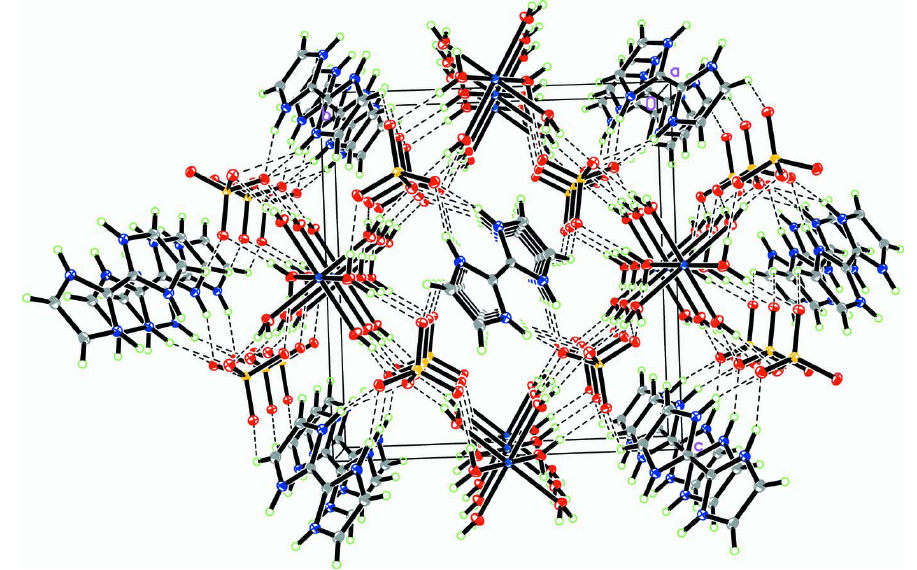
Figure 2 Packing diagram for the title compound viewed along the a